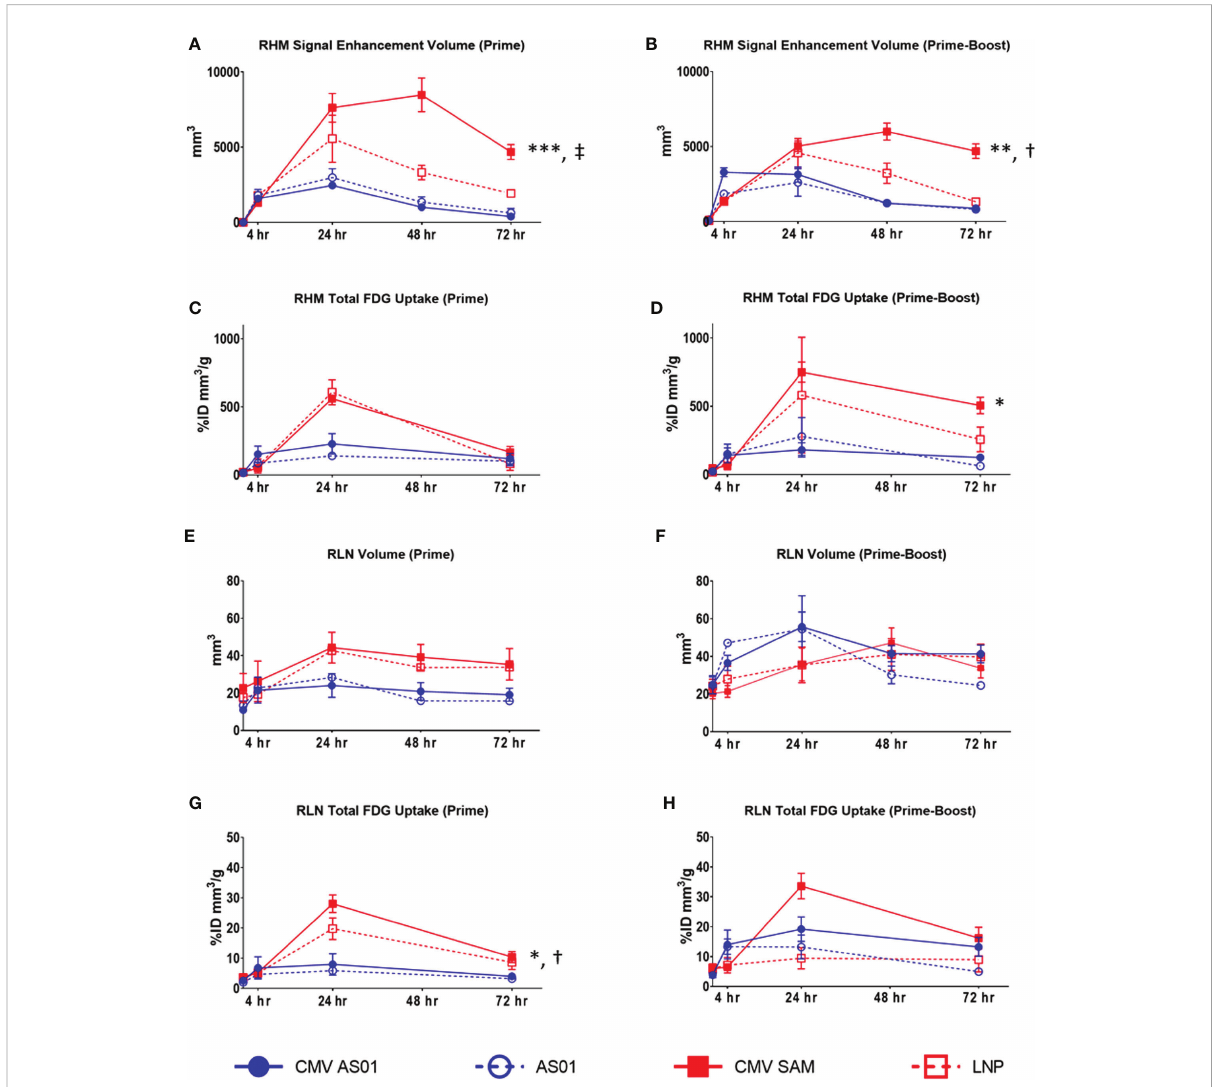
FIGURE 4 Quantitative MRI and PET data readouts in right hindlimb muscles and right popliteal lymph node. MRI enhanced signal volume in right hindlimb muscles (RHM) following Prime (A) or Prime-Boost (B) vaccine injection. 18 FDG PET derived total 18 FDG uptake in RHM following Prime (C) or Prime-Boost (D) vaccine injection. MRI measured right lymph node (RLN) volume following Prime (E) or Prime-Boost (F) vaccine injection. PET derived total 18 FDG uptake in RLN following Prime (G) or Prime-Boost (H) vaccine injection. Data are presented as mean ± SEM. *P<0.05 CMV SAM AUC vs CMV AS01 AUC; **P<0.01 CMV SAM AUC vs CMV AS01 AUC; ***P<0.001 CMV SAM AUC vs CMV AS01 AUC; † P<0.05 CMV SAM maximum vs CMV AS01 maximum; ‡ P<0.001 CMV SAM maximum vs CMV AS01